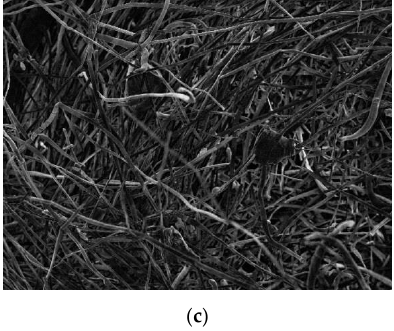
Figure 6. Eliminating the background: ( a ) Original image ( b ) Surface map of the background image ( c ) Two-dimensional image after eliminating the background.